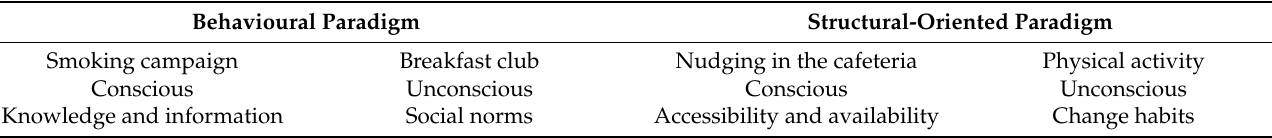
Table 1. Intervention components. The table shows our classification of the four GUB Whole School Approach based intervention components. The left column shows the behavioural part external to the structural components and the right-hand side shows the in-built components of the school environment. Behavioural Paradigm Structural-Oriented Paradigm Smoking campaign Breakfast club Nudging in the cafeteria Physical activity Conscious Unconscious Conscious Unconscious Knowledge and information Social norms Accessibility and availability Change